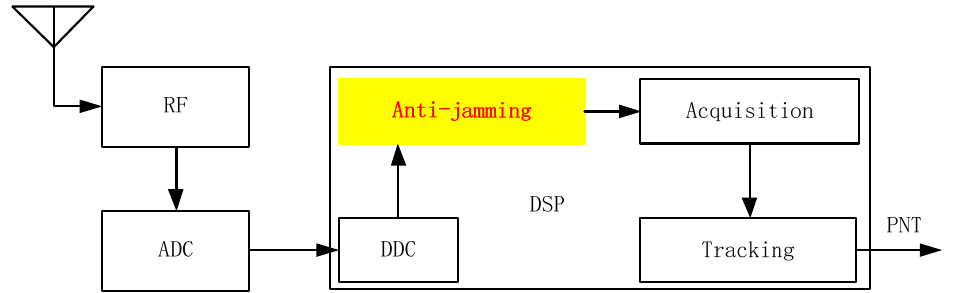
Figure 1. Satellite navigation receiver architecture.